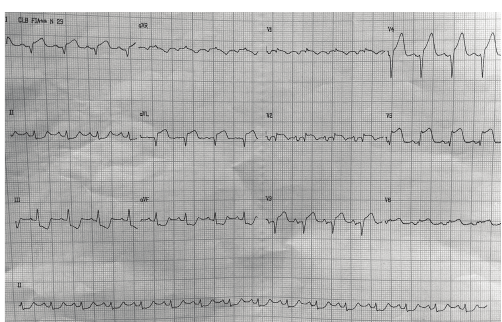
Figure 1: Postarrest electrocardiogram showing ST-segment eleva- tion of up to 5 mm in V1 to V6, DI, and aVL, with ST downslope up to 2 mm in inferior leads.